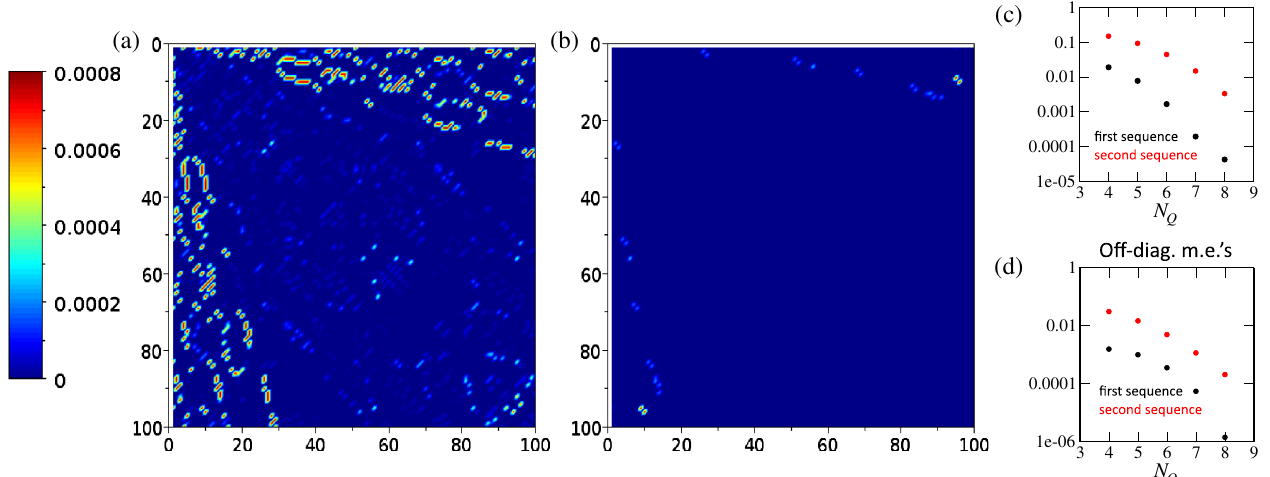
FIG. 13. The magnitude of the off-diagonal matrix elements of the analytically constructed effective charges composed from (a) four Lieb-Liniger charges, Q N ð 4 Þ , and (b) eight Lieb-Liniger charges, Q N ð 8 Þ . (c) The size of the post-quench temporal fluctuations of max max the effective charges Q N ð N Q Þ as a function of the number of charges in the linear combination. Here, the quench is performed by max preparing an N ¼ 8 , c ¼ 7200 gas in a parabolic potential of strength m ω 2 0 L 2 = 2 E F ¼ 6 . 48 released into a cosine potential of strength A ¼ 1 . We show the size of the temporal fluctuations for two sequences of effective charges, the first (in black) constructed from Lieb- Liniger charges, Q 2 m , m ¼ 1 ; … ; 8 and the second (in red) constructed from Q 2 m , m ¼ 9 ; … ; 16 . (d) The size of the off-diagonal matrix elements of these same two sequences of Q N as a function of the number N Q of Lieb-Liniger charges in the linear combination. max